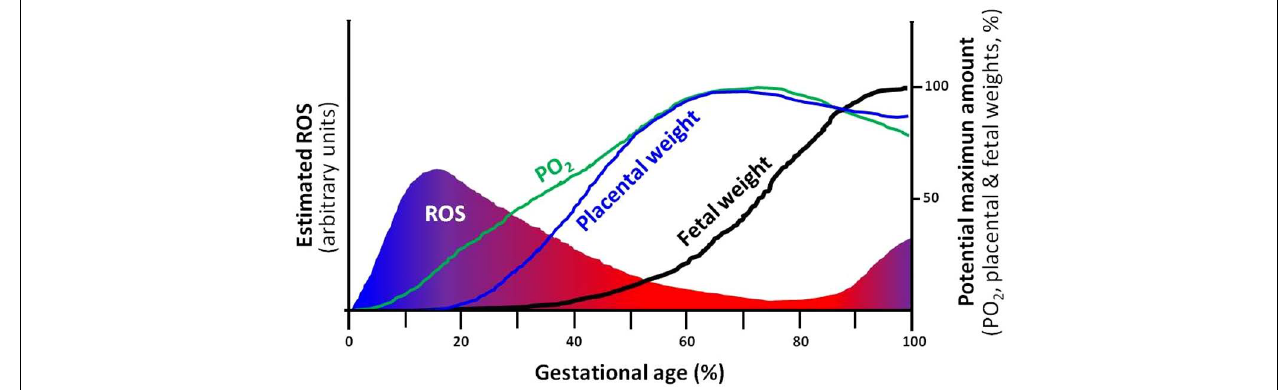
increases in PO 2 and limitation of ROS. Changes in any of the four variables, may directly affect the potential maximum amount of the rest of the variables. For instance, a decrease in PO 2 may diminish fetal growth and term weight (IUGR). ROS, reactive oxygen